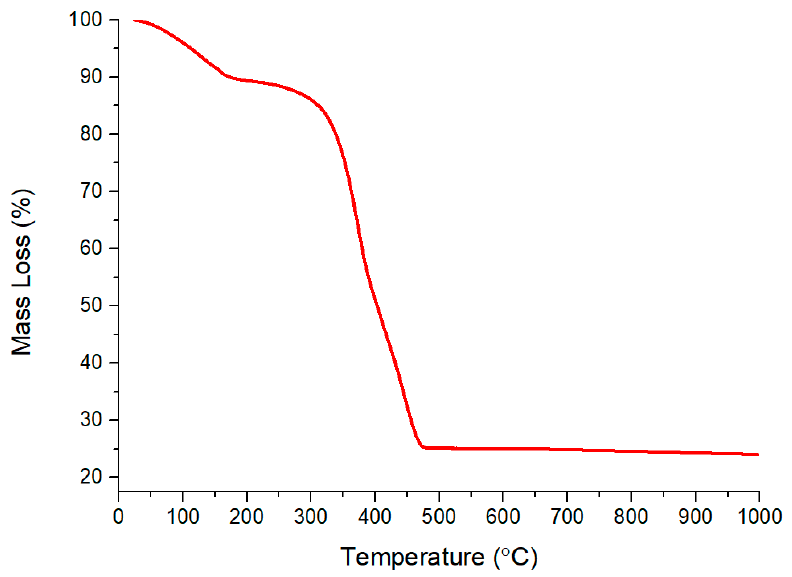
Figure 4. Thermal Behavior of TiO 2 -B 2 O 3 paste using thermogravimetric analysis (TGA). The morphology of the TiO 2 -B 2 O 3 nanoparticles (NP) structure at a temperature of 500 °C is